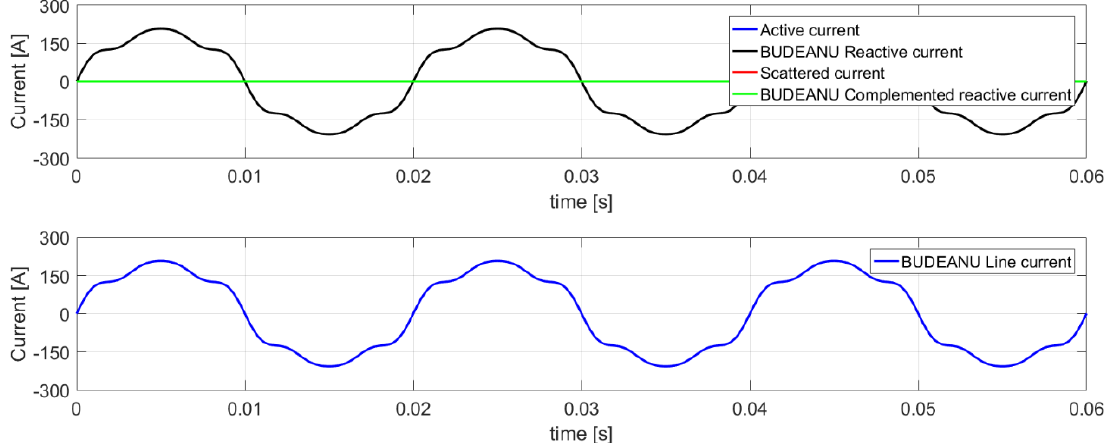
Figure 12. The waveform of the currents’ components and current of the load in development